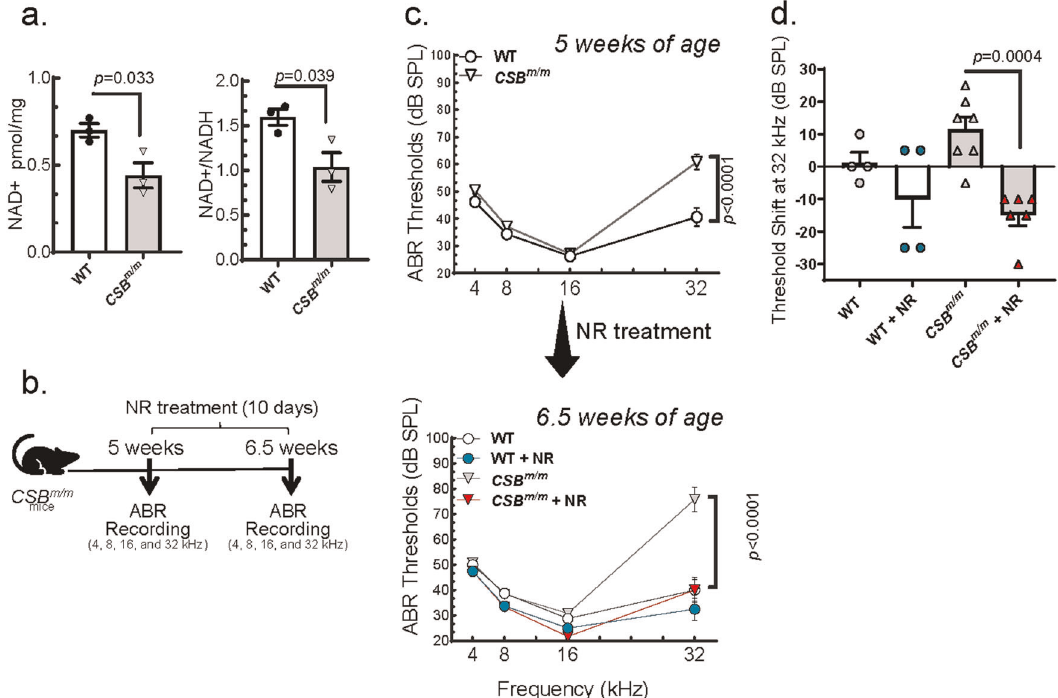
Fig. 1 NAD + supplementation prevents progressive hearing loss in CSB m/m mice. a Total NAD + levels per mg of the cochlea and relative NAD + /NADH levels were measured in the cochlea of CSB m/m and WT (6-month-old) mice ( N = 3). Two-tailed t -tests were used to